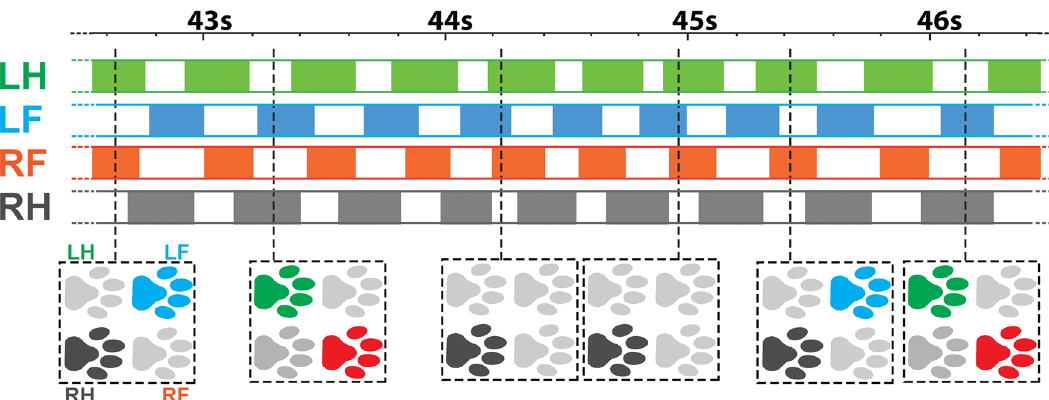
Figure 6. An example of time-resolved gait type detection using the 4-limb IMU system. The solid-color boxes in the top panel indicate the swing phase of a limb. The white space between two solid-color boxes indicates the stance phase (on-ground paw). In the lower panel, the pawprint in light gray represents off-ground paws, and the pawprint in solid colors represents on-ground paws. LH: left hindlimb, LF: left forelimb, RF: right forelimb, RH: right